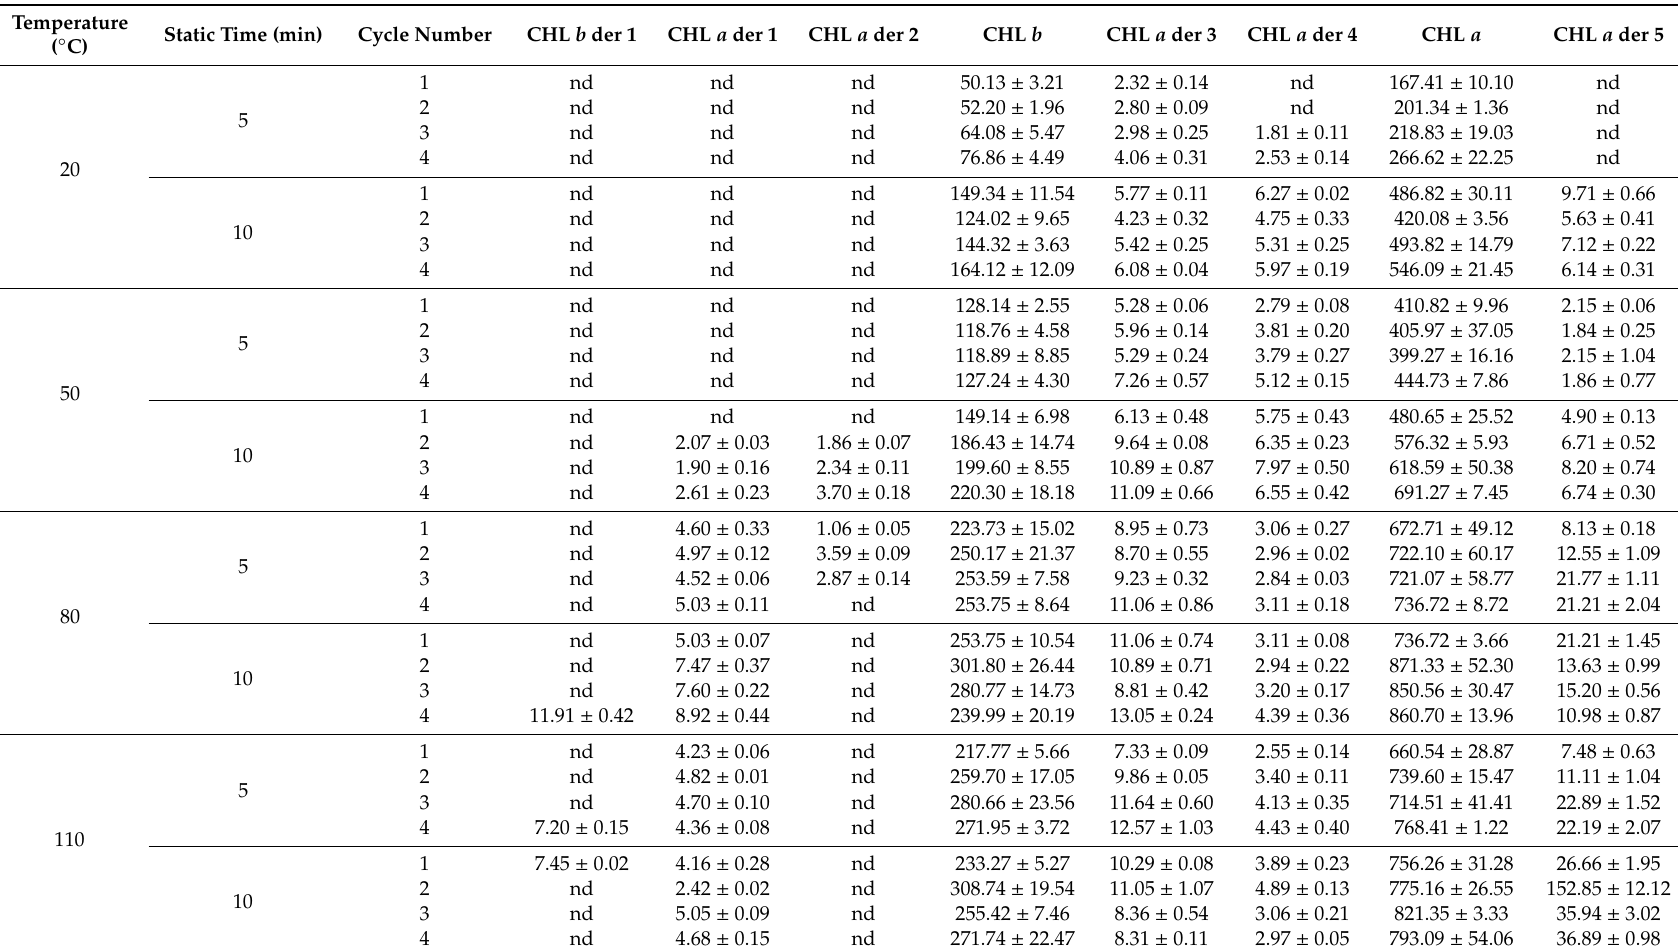
Table 4. Nettle leaves chlorophylls (mg100 g − 1 dm) in extracts obtained at ASE di ff erent